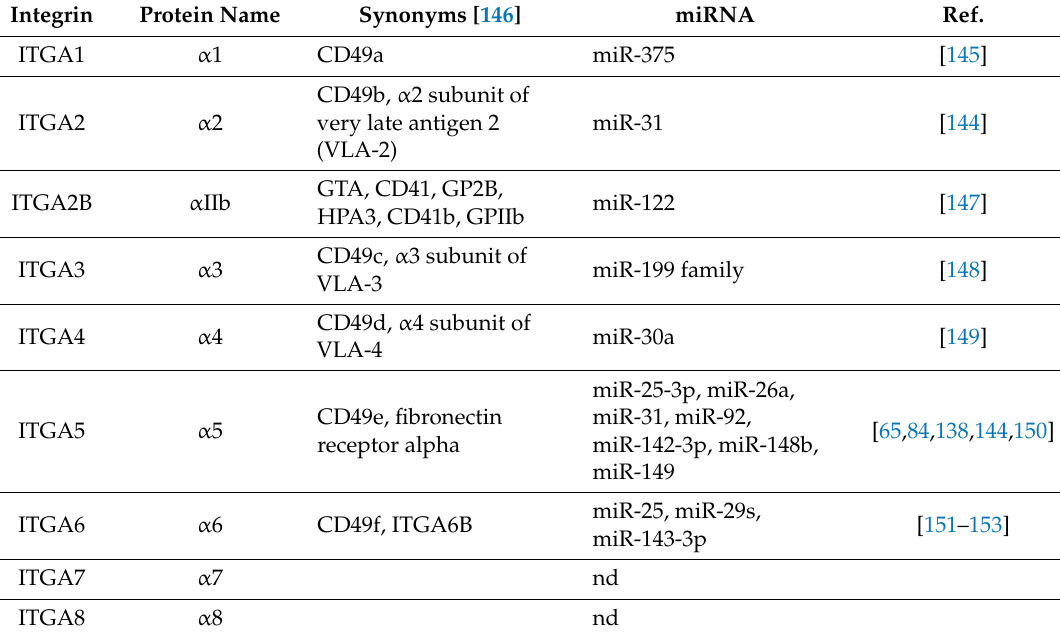
Table 3. The direct regulation of integrin subunits by miRNAs in cancer